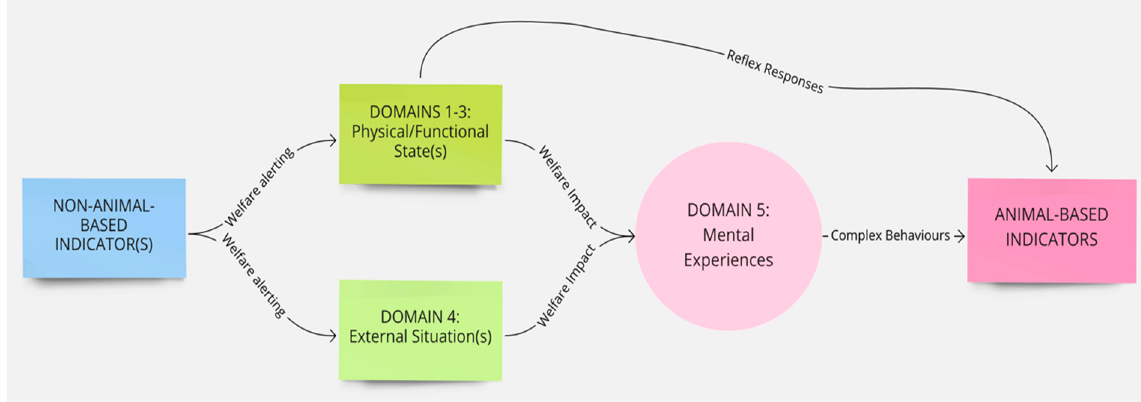
Figure 2. The logical link between physical/functional states can be used to validate animal welfare assessments using observable or measurable objective indicators applied to each of the first three physical/functional domains and their relationship to proposed mental experiences in Domain 5. Observable and measurable evidence of impacts and benefits is collated in Domains 1 to 4 and used to infer mental experiences in Domain 5. Validation of the link between situation-related experiences arising due to the animal’s perception of its external situation (Domain 4) is more challenging than for the link between physical/functional states (Domains 1 to 3) and proposed mental experiences.